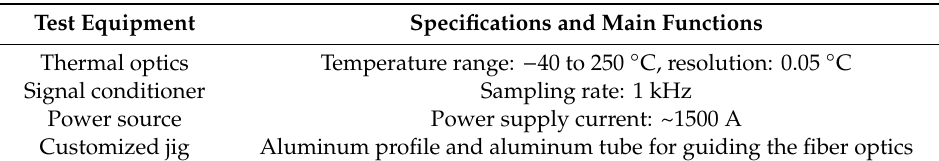
Table 2. Experiment equipment.